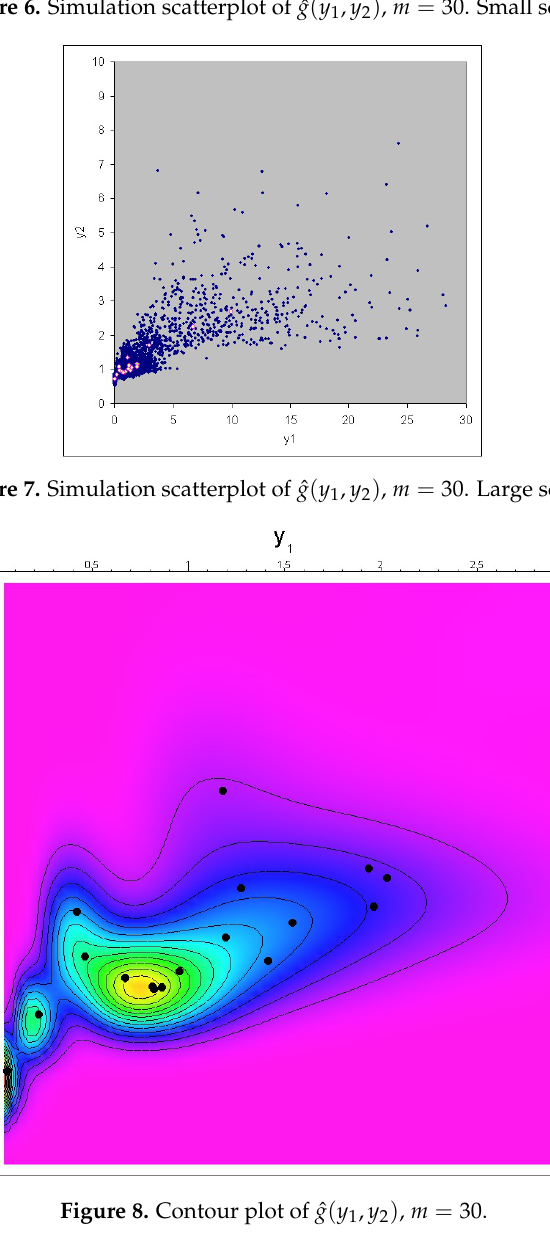
Figure 6. Simulation scatterplot of ˆ g ( y 1 , y 2 ) , m = 30. Small scale.